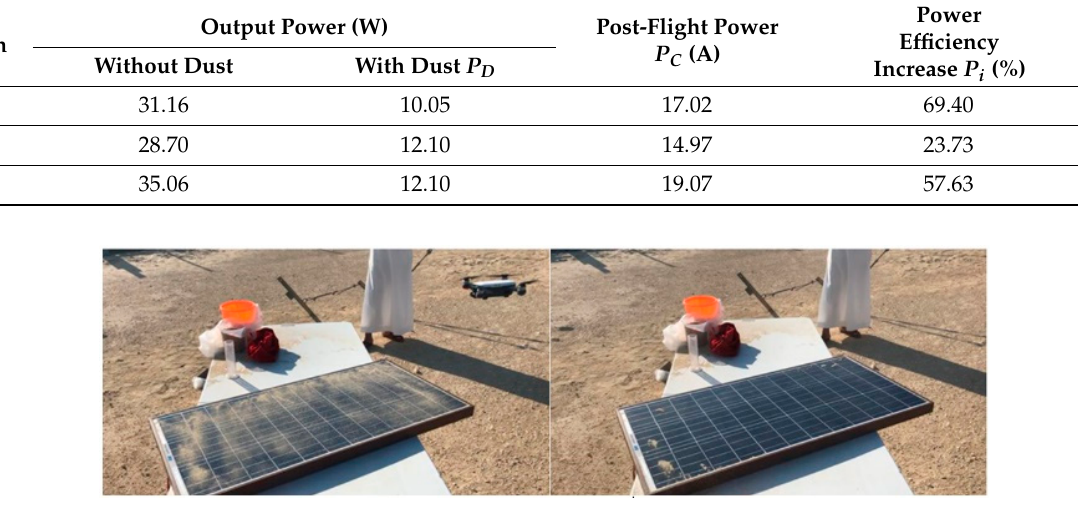
Table 3. Power analysis of different drone flight methods (20 CC). Table 5. Power analysis of different drone flight methods (100 CC).